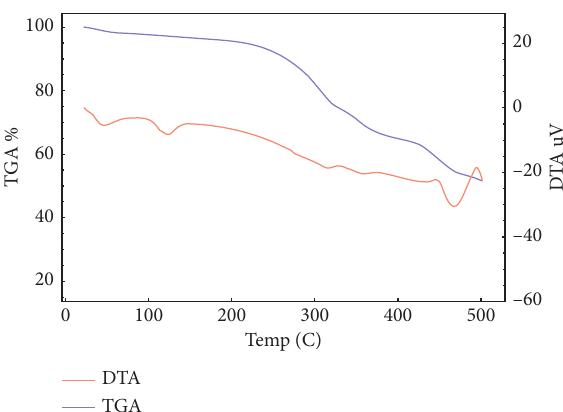
Figure 4: A perspective view of the complete coordination around Mn(II) complex.